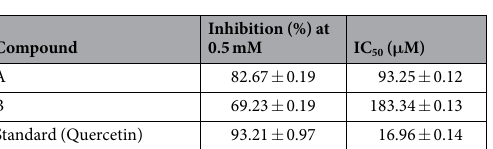
White crystalline solid Yield : 5 mg